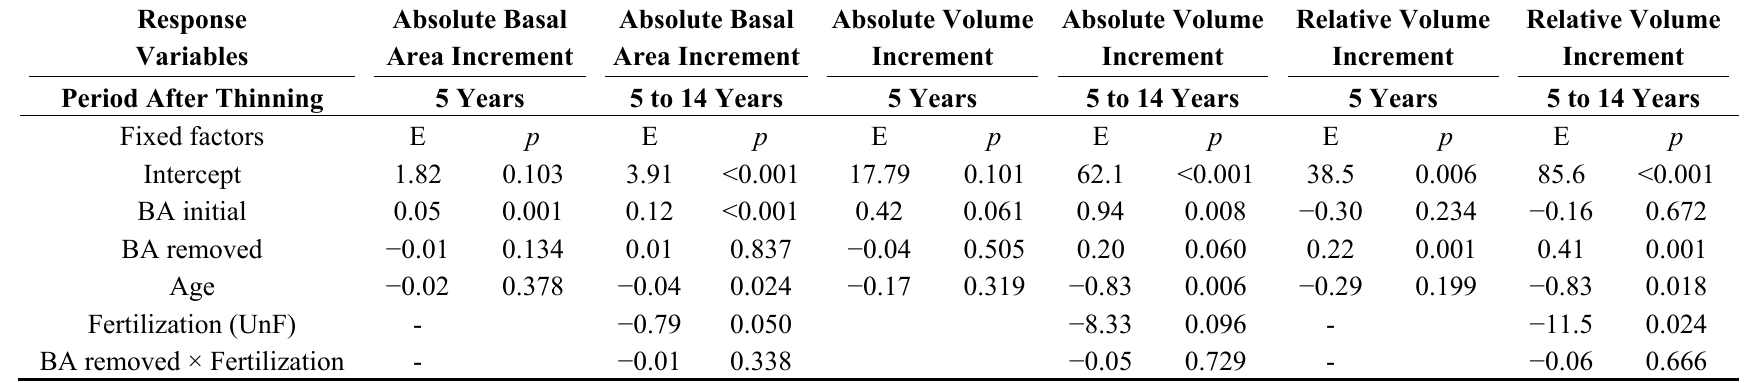
Table 4. Jack pine stand basal area increment, absolute and relative volume increment in response to commercial thinning and fertilization over periods of 5 and 5 to 14 years. Fertilization was conducted within experimental sub-plots 3 to 5 years after thinning. Effects of initial stand basal area and age, basal area removed by commercial thinning, fertilization and selected interactions assessed by means of linear mixed